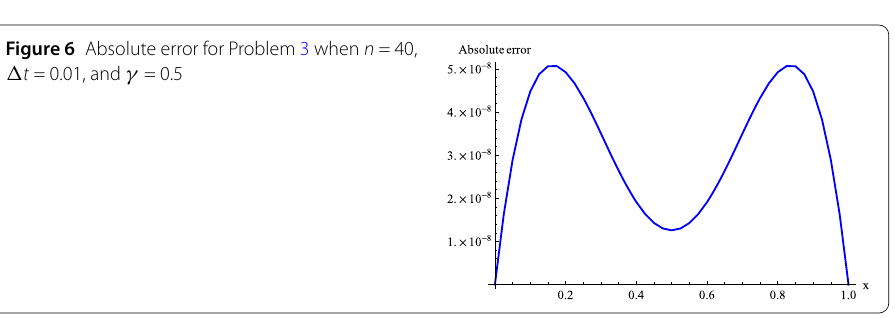
Figure 6 Absolute error for Problem 3 when n = 40, (cid:12) t = 0.01, and γ =